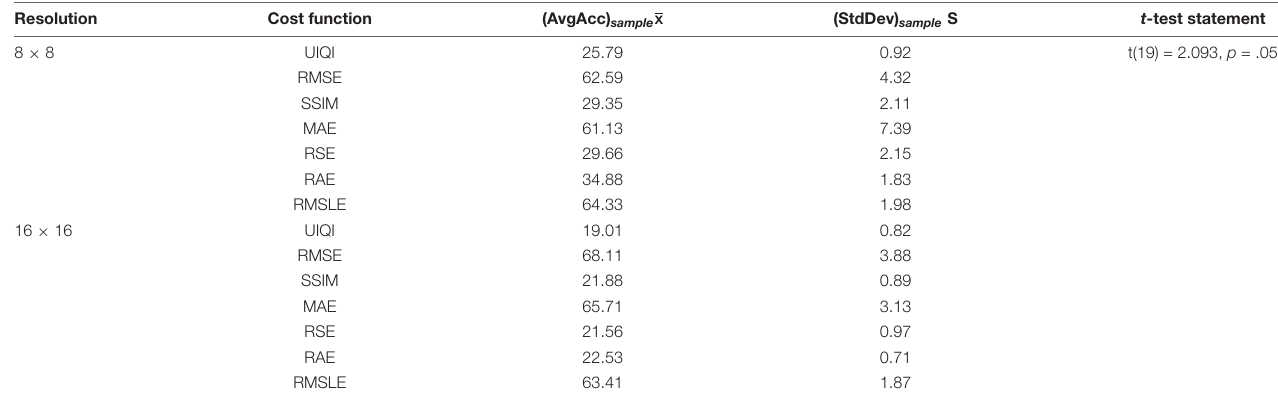
TABLE 6 | Multiple resolution t -test statement in APA style for different cost functions used for image reconstruction (two-tailed t -distribution with no inequality in alternate hypothesis), the null hypothesis is H 0 : µ = x, and the alternative hypothesis is H a : µ (cid:54)= x.